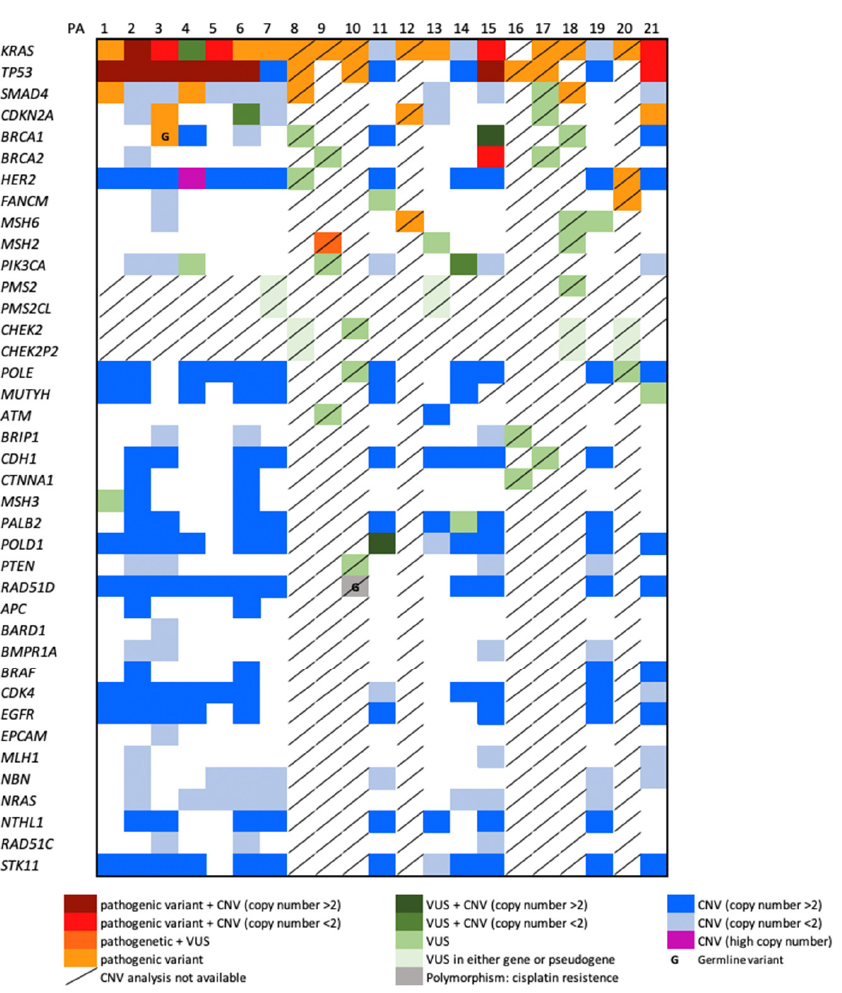
Figure 2. Mutational landscape of investigated genes. The panel shows single nucleotide variants (SNV), ins/del and also copy number variations (CNV) of the entire gene (>2 or <2). Germline variants are indicated with “G”. Cases or genes for which CNV analysis was not available or unreliable for the presence of pseudogenes are indicated by a slash.